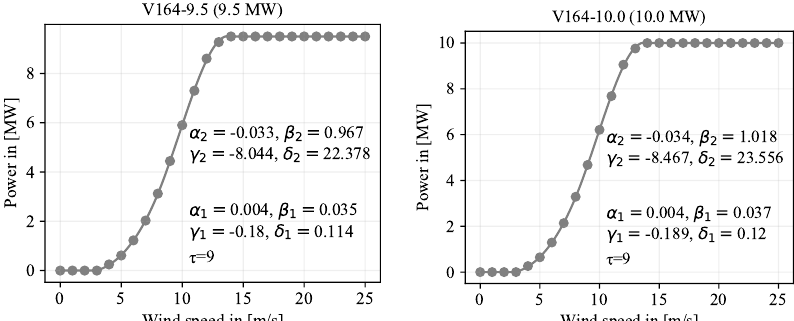
( m ) Power curve of wind turbine V164-9.5.